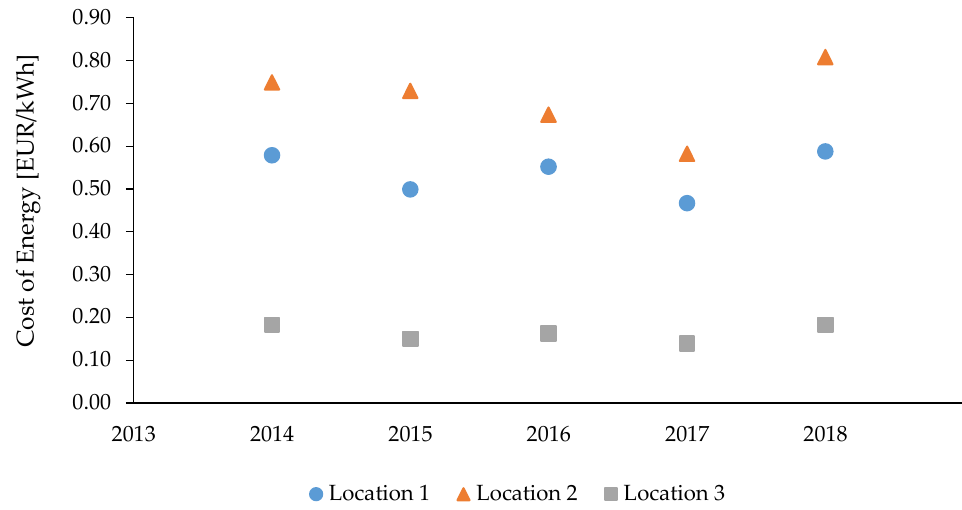
Figure 12. Unit cost of energy production at the three locations in 2014–2018.